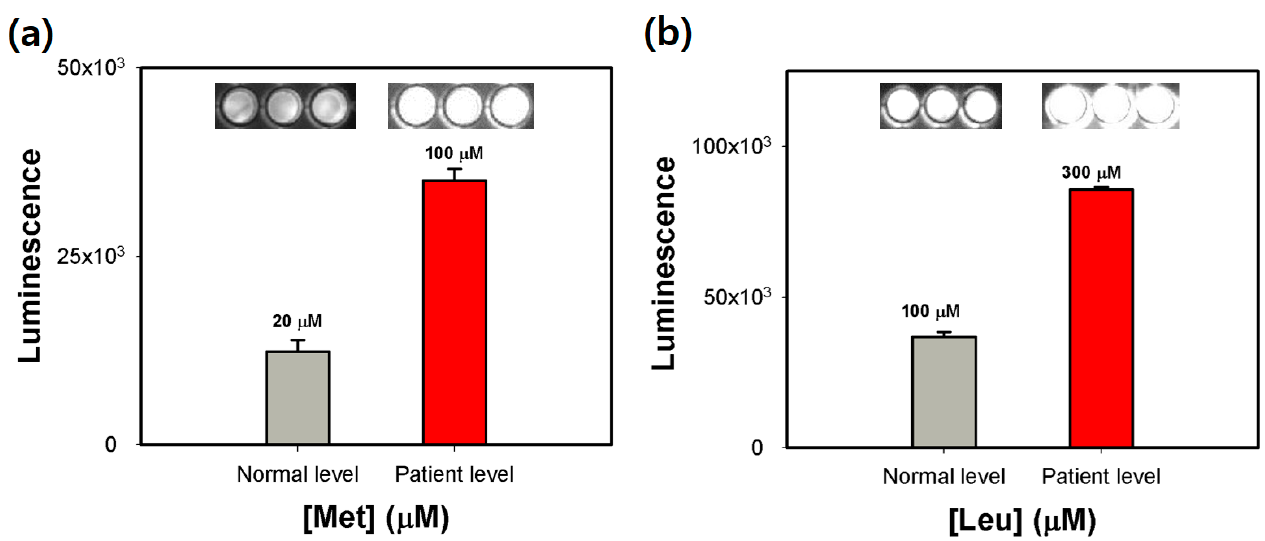
Figure 6. Diagnosis of ( a ) homocystinuria and ( b ) maple syrup urine disease using the ready-to-use amino acid array comprising Met and Leu auxotrophic E. coli strains with trehalose after storage for 3 months. Error bars represent standard errors derived from three independent measurements.